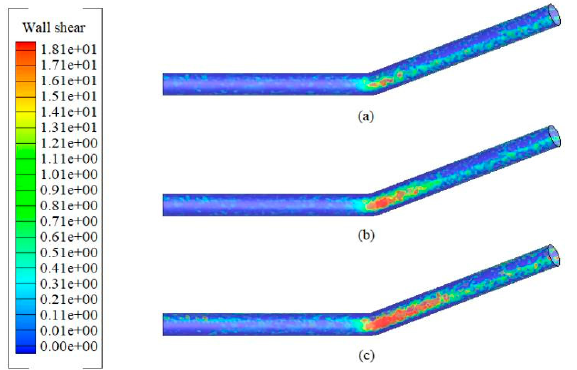
Figure 7. Contours of the wall shear stress in an upward-inclined pipe (30°) carrying 30% water– 70% gas at different gas superficial velocities, where ( a ) 1 m/s, ( b ) 3 m/s, and ( c ) 5 m/s.